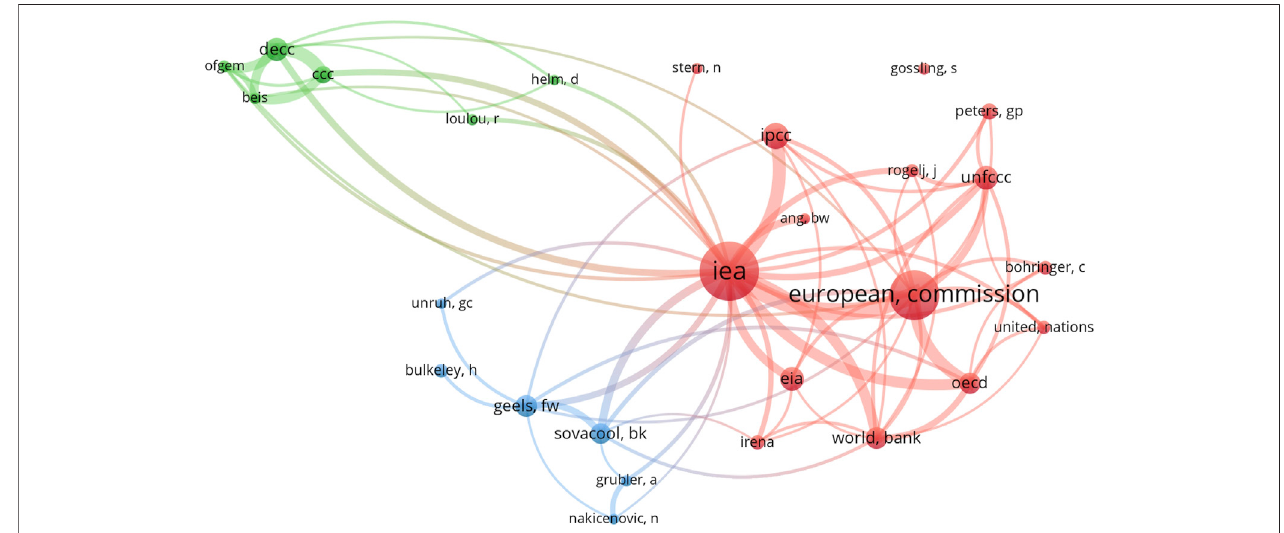
FIGURE 2 | Author co-citation